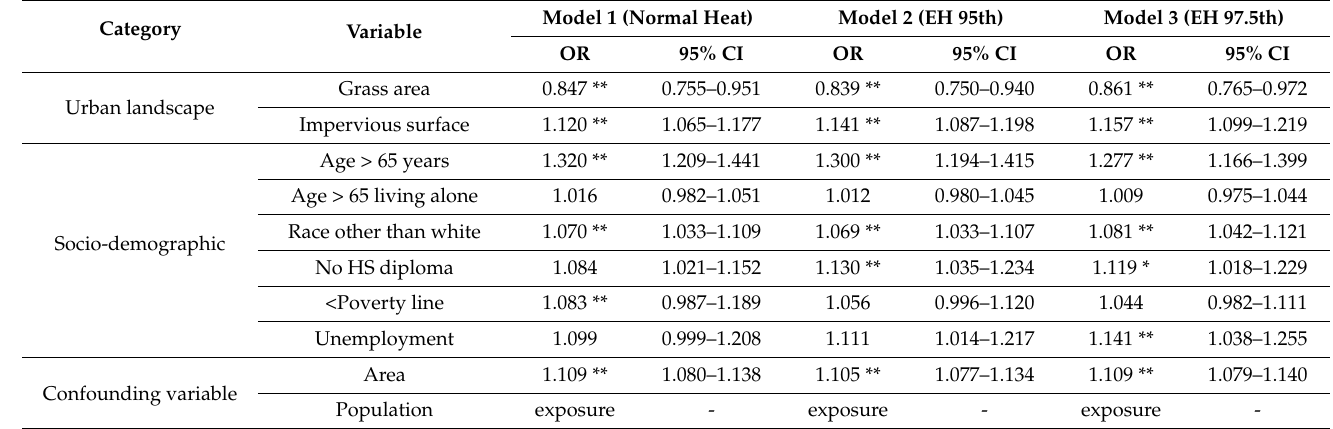
Table 3. Odds ratios (ORs) and 95% confidence intervals for heat-related EMS incidents during normal, 95th extreme, and 97.5th extreme heat days with multivariate